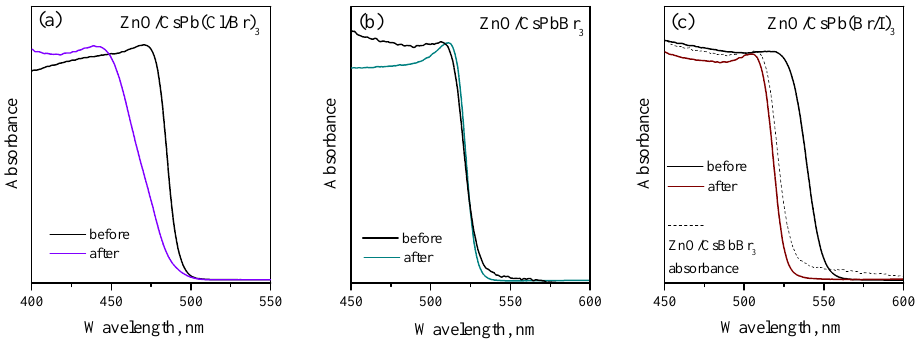
Figure 12. Absorption spectra of ZnO/CsPb(Cl/Br) 3 ( a ), ZnO/CsPbBr 3 ( b ) and ZnO/CsPb(Br/I) 3 ( c ) nanocomposites before and after blue light irradiation (470 nm, 40 mW/cm 2 , 48 h). On the figure ( c ) a dashed line shows the absorption spectrum of ZnO/CsPbBr 3